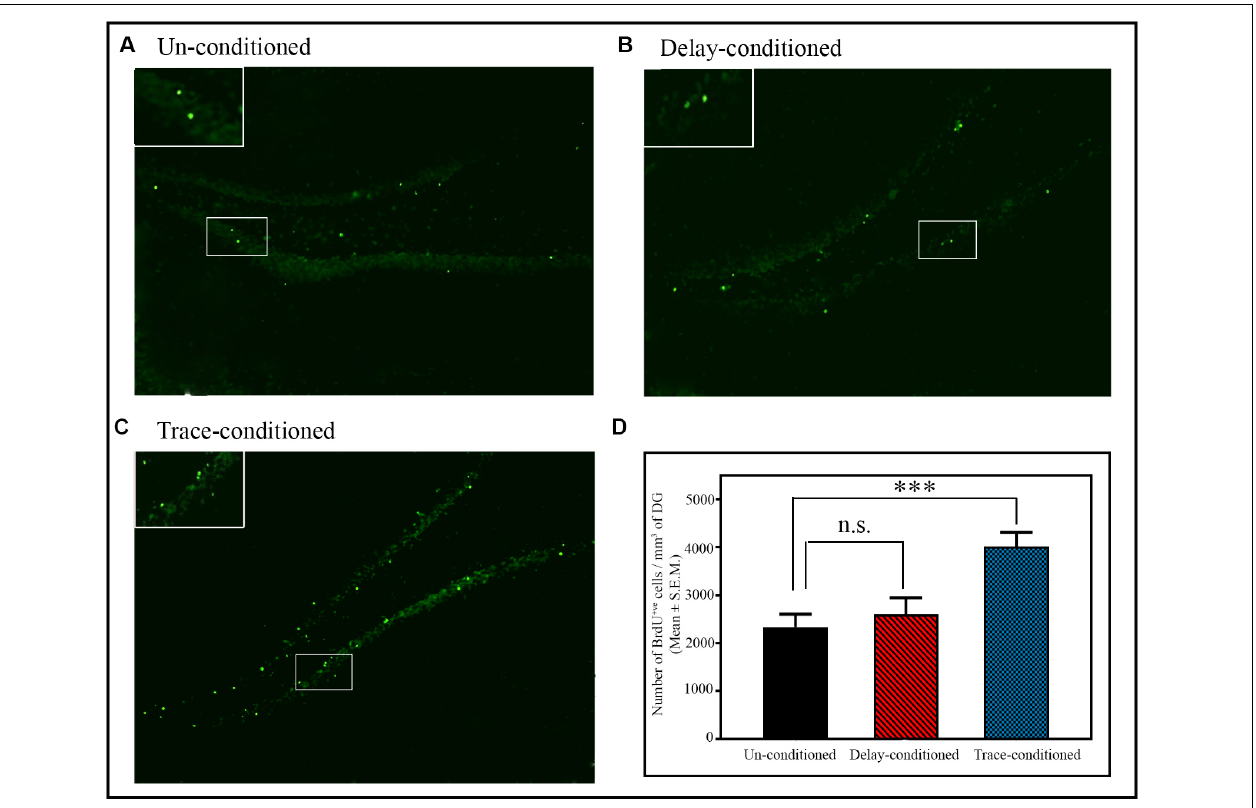
FIGURE 3 | The number of BrdU +ve cells in the dentate gyrus (DG) of the hippocampus after delay- and trace-conditioning. Photomicrographs of the hippocampus (10 × magnification) of (A) un-conditioned and (B) delay-conditioned and (C) trace-conditioned animals. Green dots show the BrdU +ve cells. Magnified views of BrdU +ve cells are shown in the inset. (D) An average number of BrdU +ve cells/mm 3 of DG in the un-conditioned ( n = 6), delay-conditioned ( n = 6) and trace-conditioned animals ( n = 7). The BrdU +ve cells significantly increased in the trace-conditioned animals ( ∗∗∗ p < 0.001; F (2,18) = 8.29, one-way ANOVA followed by Tukey post hoc ), compared to the un-conditioned control animals. The BrdU +ve cells in the delay-conditioned animals were comparable to the un-conditioned control animals. n.s., not-significant.